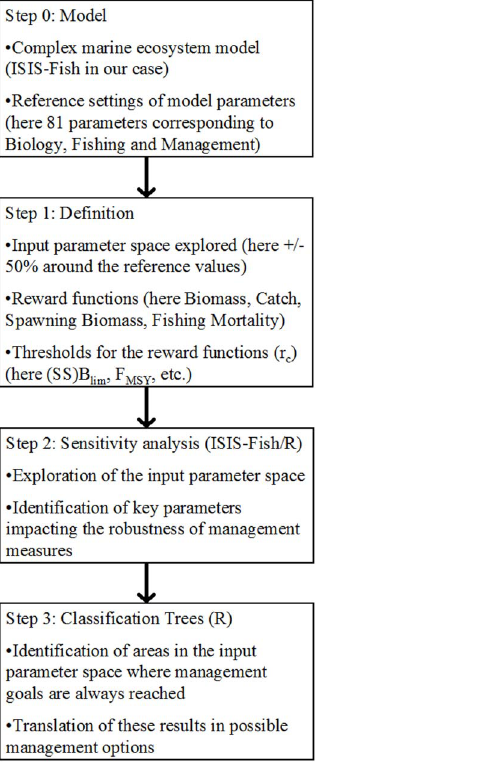
Figure 1. The general approach used to identify areas of interest in the input parameters subspace. Once the model has been built and parameters identified (step 0) output variables to be studied and thresholds corresponding to these variables can be chosen